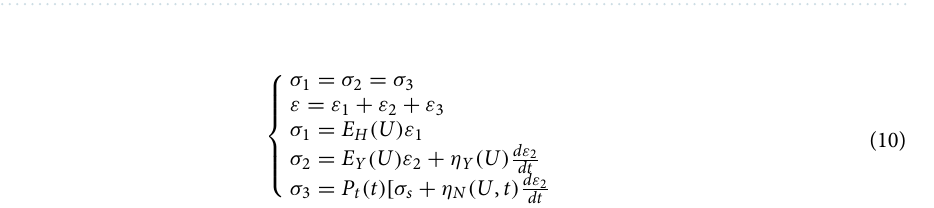
Table 5. Pre-peak unloading damage model identification parameters under non-yield stress conditions (same damage